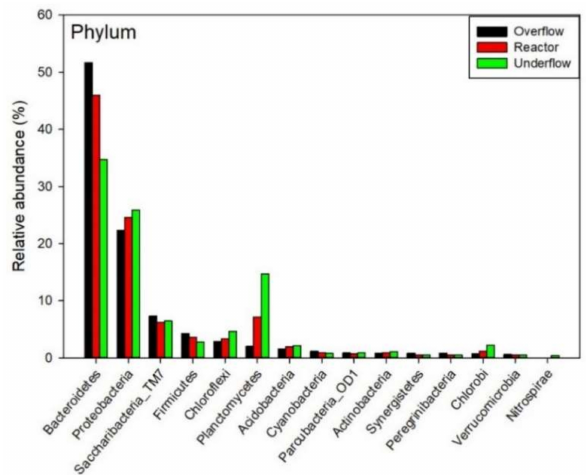
Figure 7. Taxonomic classification of the bacterial communities at each sampling point at the phylum level.